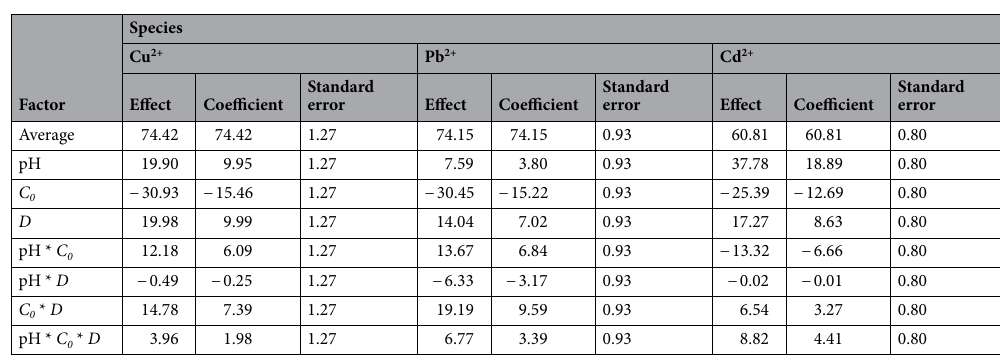
Table 4. Statistical parameters of 2 3 factorial design-for removal